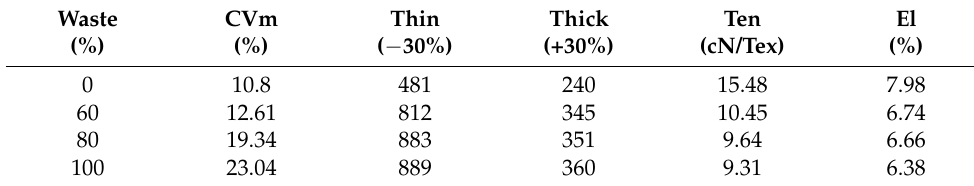
Table 6. The quality of blended yarn (W1 and V1 blend).